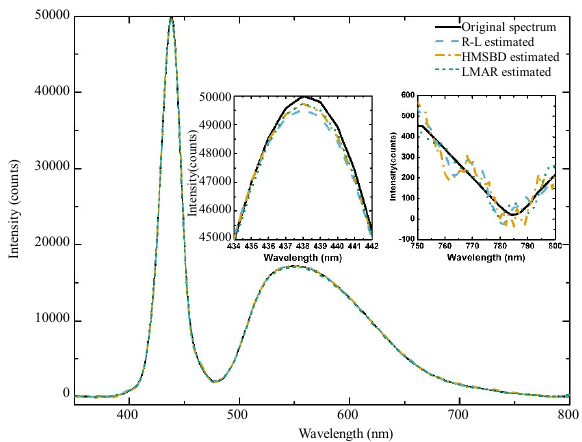
Fig. 8 Original spectrum and corrected spectra of white LED 2#.